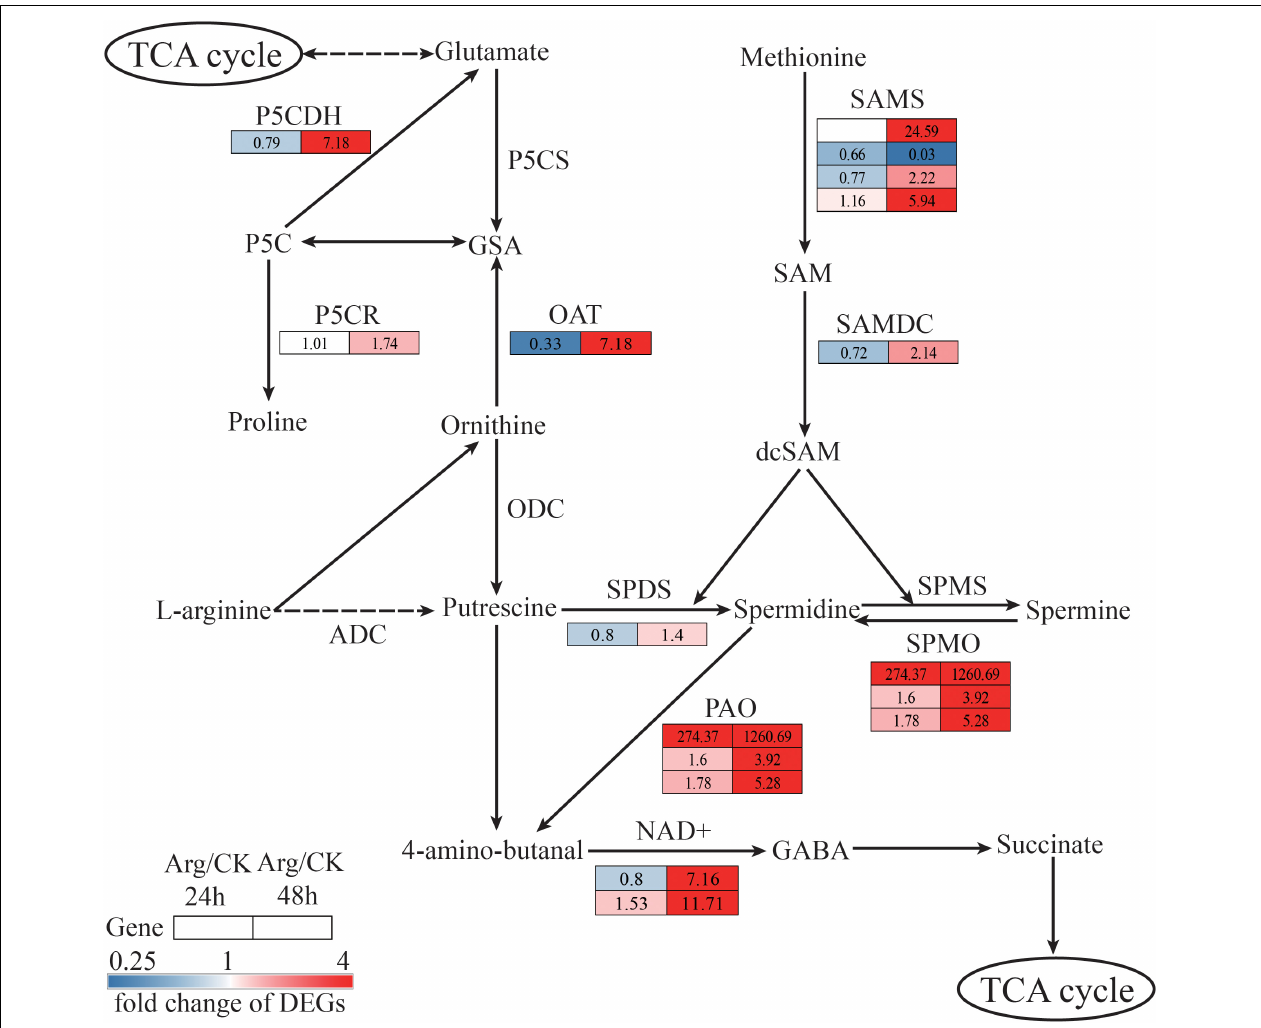
FIGURE 5 | The construction of hypothetical arginine, proline, polyamines, and GABA metabolism pathway based on the KEGG database. The solid arrow indicates one-step reaction, the dotted arrow indicates poly-step reaction and omitted intermediate steps. The same row represents the abundance change of one unigene at 24 h (left column) and 48 h (right column), the number in each square beside the enzyme code refers to the fold change of corresponding DEGs. Red and blue squares indicate upregulation and downregulation, separately, while white means are not expressed at this time point. KEGG, Kyoto Encyclopedia of Genes and Genomes; GABA, γ -aminobutyric